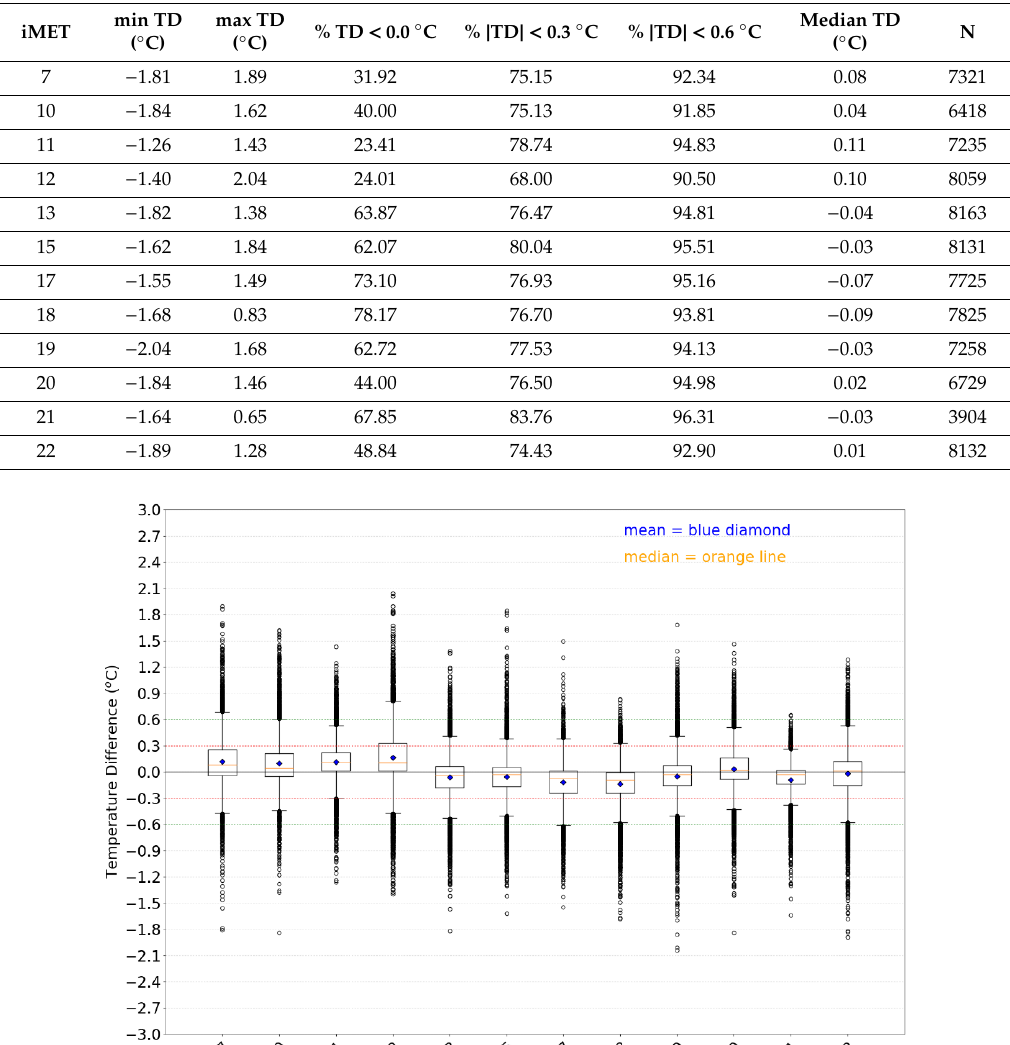
Table 4. Statistics of temperature differences (TD) between each iMET-XQ sensor and all other iMET-XQ sensors.